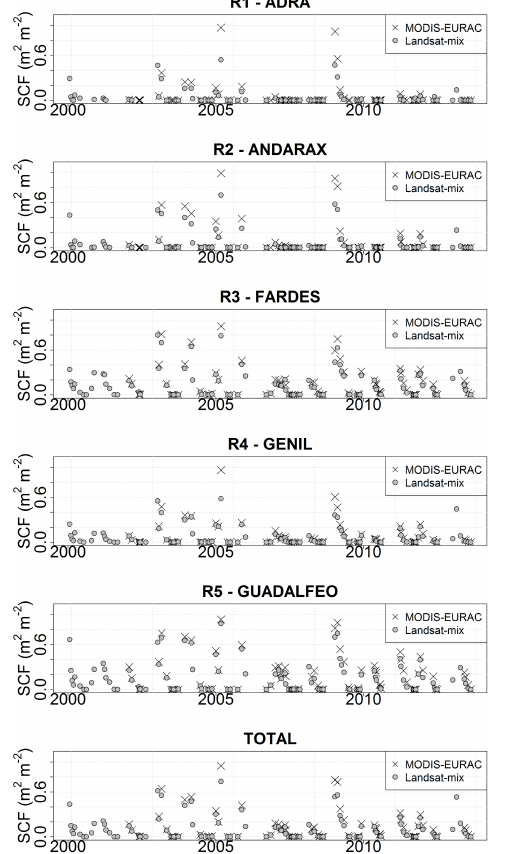
Figure 2. Comparison between SCF evolution of both products MODIS-EURAC (black crosses) and Landsat-mix (gray dots) in the 108 overlapping dates, in each of the regions selected and in the whole study